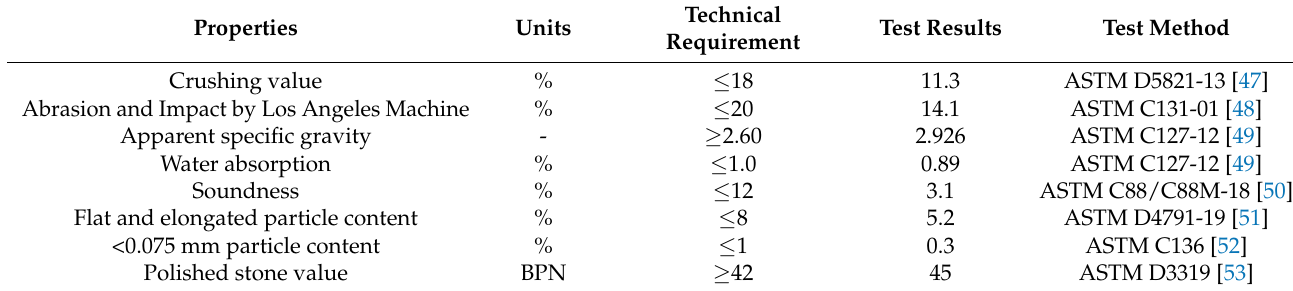
Table 3. Technical requirements for coarse aggregates.